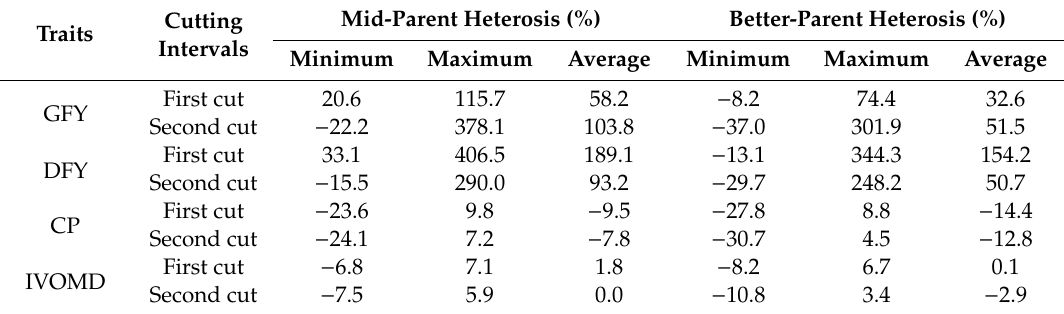
Table 5. Summary of MPH and BPH for forage linked traits.